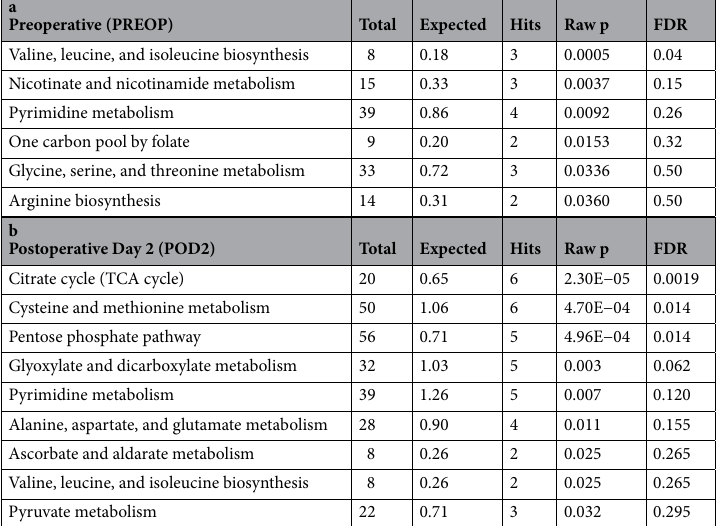
Table 3. Biochemical pathways enriched with significant metabolites at preoperative (PREOP) and postoperative day 2 (POD2). Enriched pathways ( p < 0.05) were identified using MetaboAnalyst 4.0 81–83 , which considers both metabolite over representation within a pathway and location importance 41,84 . A metabolite was included in biological systems analysis if it showed significant differentially quantified concentrations (nominal p value < 0.05 (PREOP), Benjamini–Hochberg (BH) p value < 0.05 (POD2)) in two or more statistical tests. “Total” represents the number of metabolites in the pathway, while “Hits” is the number of “input” metabolites found in the